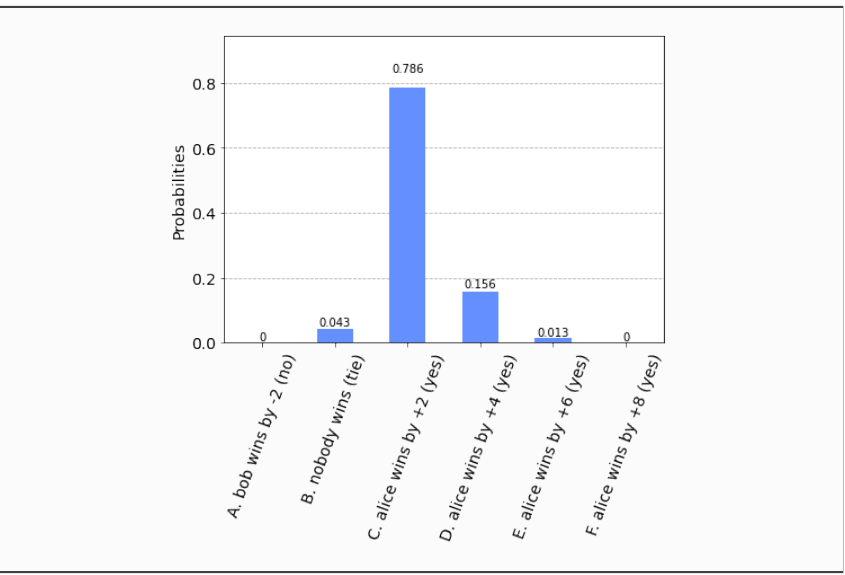
Figure 9. The possible outcomes and their probabilities when r A = 0.15 and r B =